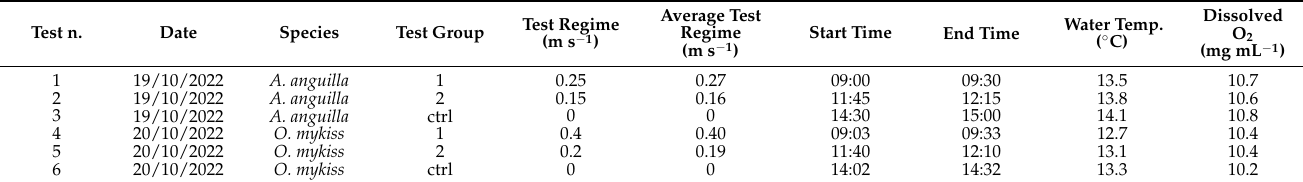
Table 1. Schedule, regime, and environmental conditions of experimental